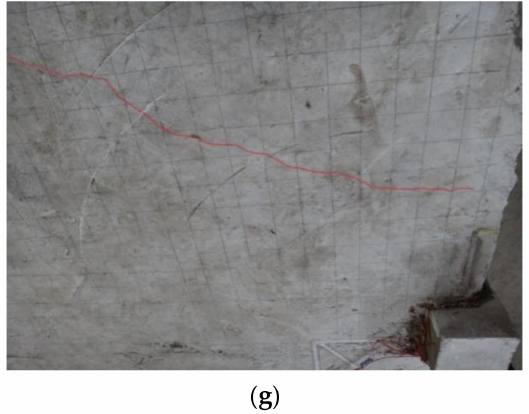
Figure 7. Overall views of the frame specimen’s deformed shapes at the final stage, ( a ) aerial view of frame specimen at the final stage, ( b ) deformed shape of beam LB-1, ( c ) deformed shape of beam TB-1, ( d ) crack pattern at top surface of slabs. ( e ) deformed shape of slab P1, ( f ) deformed shape of slab P2, ( g ) deformed shape of slab